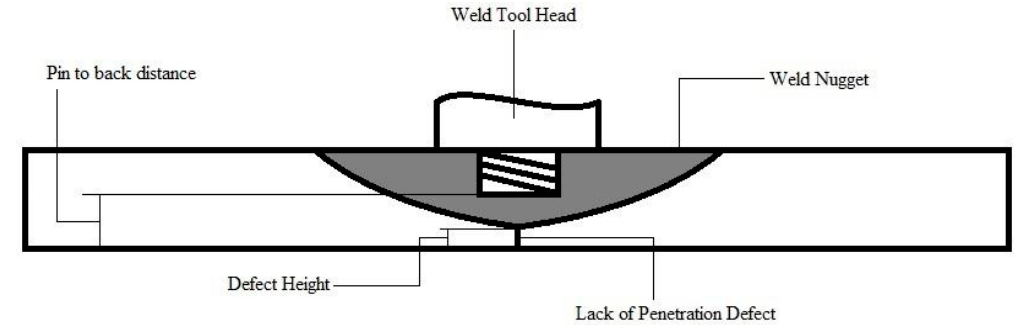
Figure 4. Lack of penetration defect where the pin does not penetrate material completely.